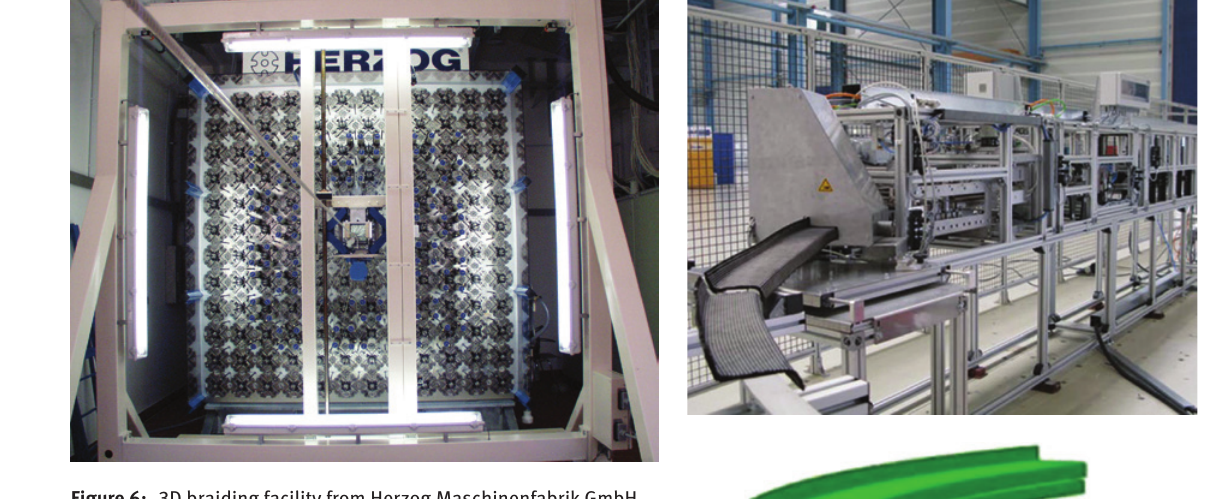
They were processed at a maximum speed of 2 m/min [26].